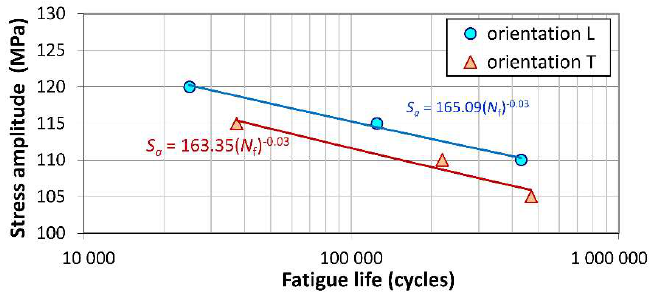
Figure 14. S – N curves of Cu-ETP R220 base material specimens.